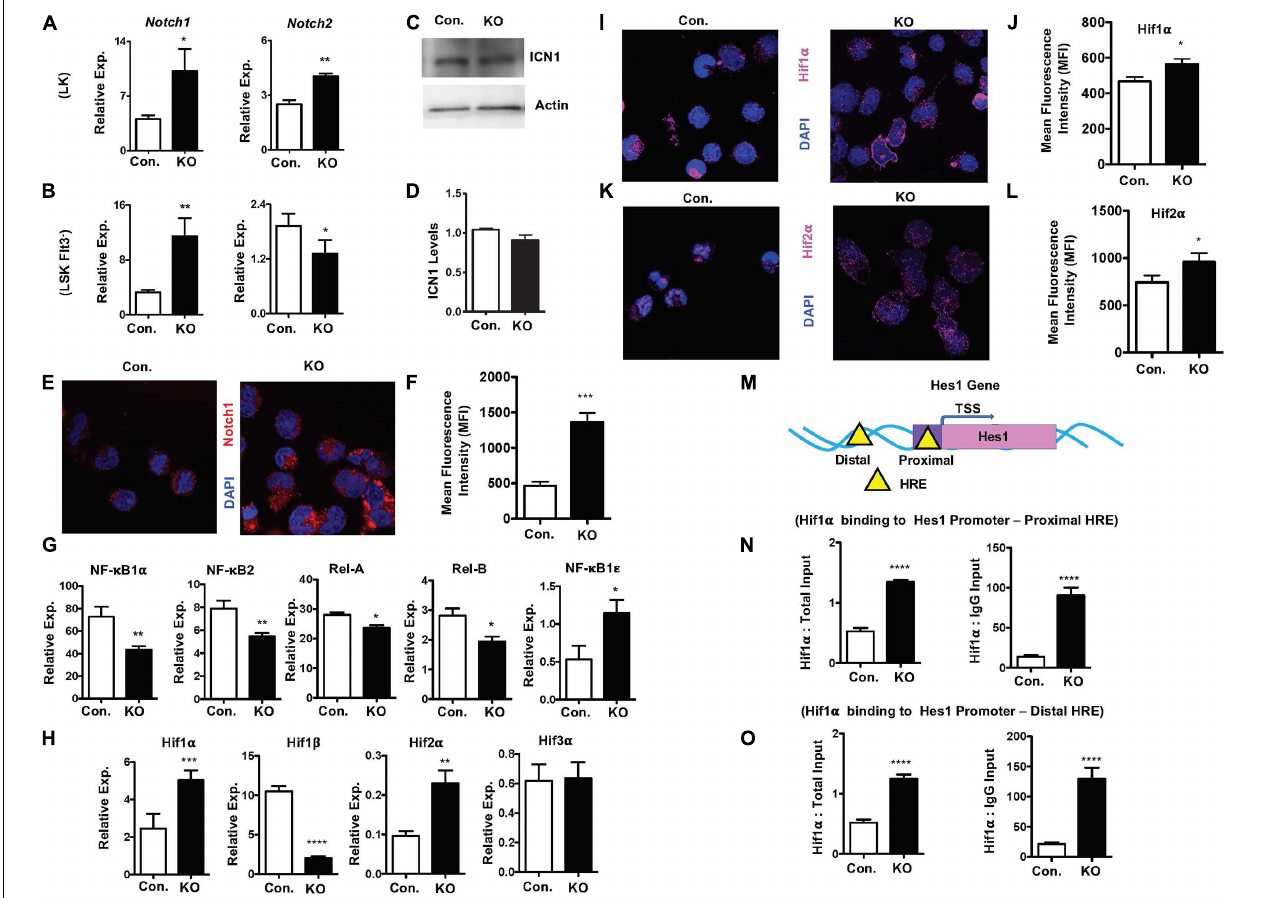
FIGURE 7 | Rbpj loss results in elevated Hif expression and functions. (A,B) Real time PCR analysis of notch1 and notch2 mRNA expression in purified LK (A) and Flt3 − LSK (B) cells of the BM from KO and control mice. Expression levels were normalized to HPRT levels. Data are representative of three independent experiments. (C) Western blot analysis of Notch1 protein in Lin − BM cells of KO and control mice. Data are representative of three independent experiments. (D) Quantification of proteins from western blots shown in (C) . Notch1 protein levels were normalized to actin protein levels in each lane, respectively. Data are pool of two independent experiments. (E) Representative immunofluorescence images of Notch1 and DAPI in purified Lin − BM cells of KO and control mice. (F) Quantification of nuclear Notch levels from (E) . Data points include n = 30 individual cells from two independent experiments. (G) Real time PCR analysis of NF- κ B target genes in purified Lin − BM cells from KO and control mice. Expression levels were normalized to HPRT levels. Data are representative of three independent experiments. (H) Real time PCR analysis of Hif1 α , Hif2 α , Hif3 α , and Hif1 β target genes in purified Lin − BM cells from KO and control mice. Expression levels were normalized to HPRT levels. Data are representative of three independent experiments. (I,K) Representative immunofluorescence images of Hif1 α and DAPI (I) and Hif2 α and DAPI (K) in purified Lin − BM cells of KO and control mice. (J,L) Quantification of nuclear Hif1 α levels (J) from (I) and Hif2 α levels (L) from K . Data points include n = 60 (J) and n = 30 (L) individual cells from two independent experiments. (M) Diagrammatic representation of Hes1 gene indicating the presence of Hif binding HRE sites in both the promoter (proximal) and 5 (cid:48) upstream (distal) regulatory regions. (N,O) ChIP analysis of Hif1 α binding to the promoter (N) and 5 (cid:48) upstream regulatory (O) regions of Hes1 in purified Lin − cells of BM from KO and control mice. Shown are the real-time PCR data of Hif1 α immunoprecipitates, which were normalized to either total input (left) or IgG control (right) immunoprecipitates. Data are representative of two independent experiments. All data represent mean ± SEM. Two-tailed Student’s t- tests were used to assess statistical significance (* P < 0.05; ** P < 0.01; *** P < 0.001; **** P <